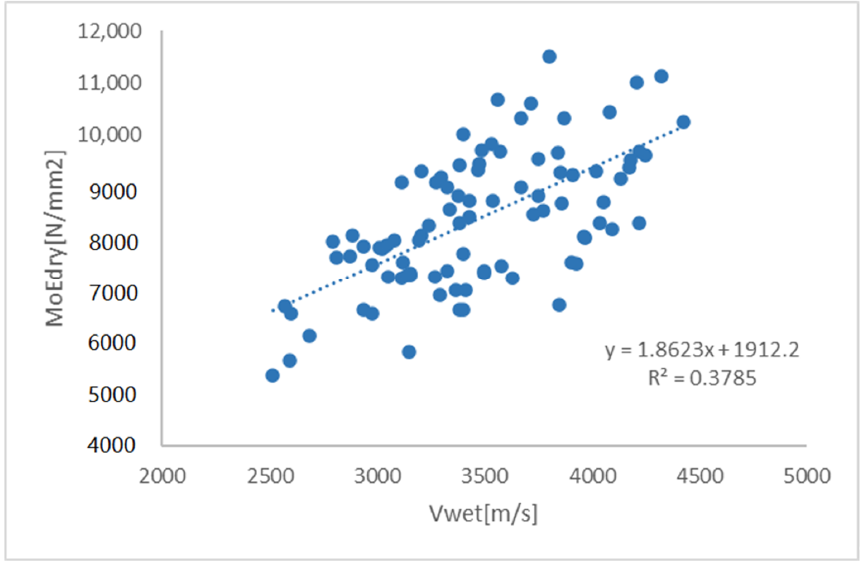
Figure 14. MoE dry vs. wave velocity in wet condition.